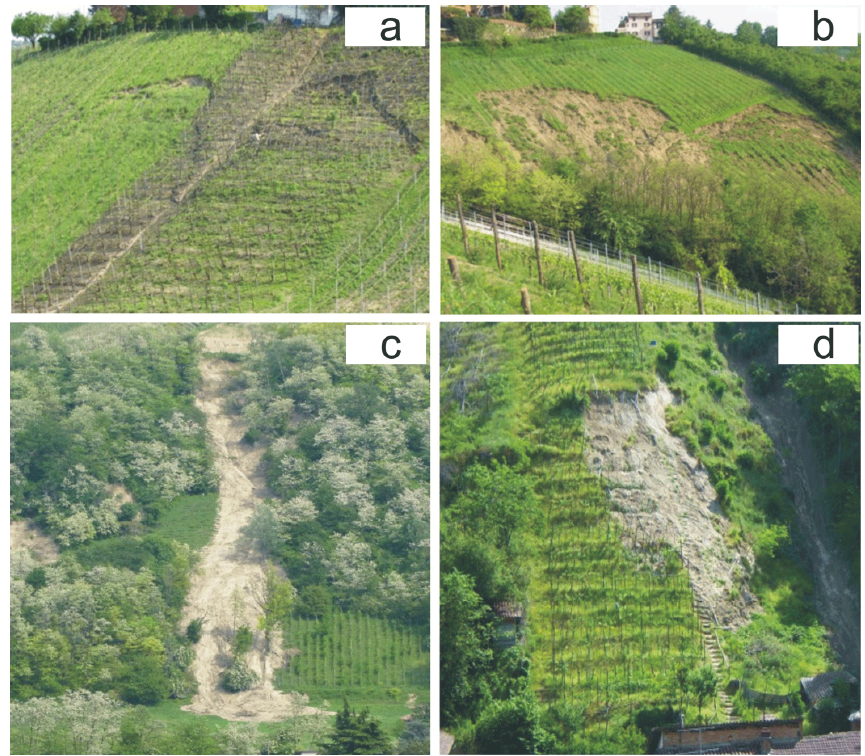
Figure 3. Examples of rainfall-induced shallow landslides that occurred in the study area during the event of 27–28 April 2009, according to the classifications of Cruden and Varnes (1996) and Campus et al. (1998): (a) incipient translational slides, (b) translational soil slides, (c) complex landslides and (d) disintegrating soil